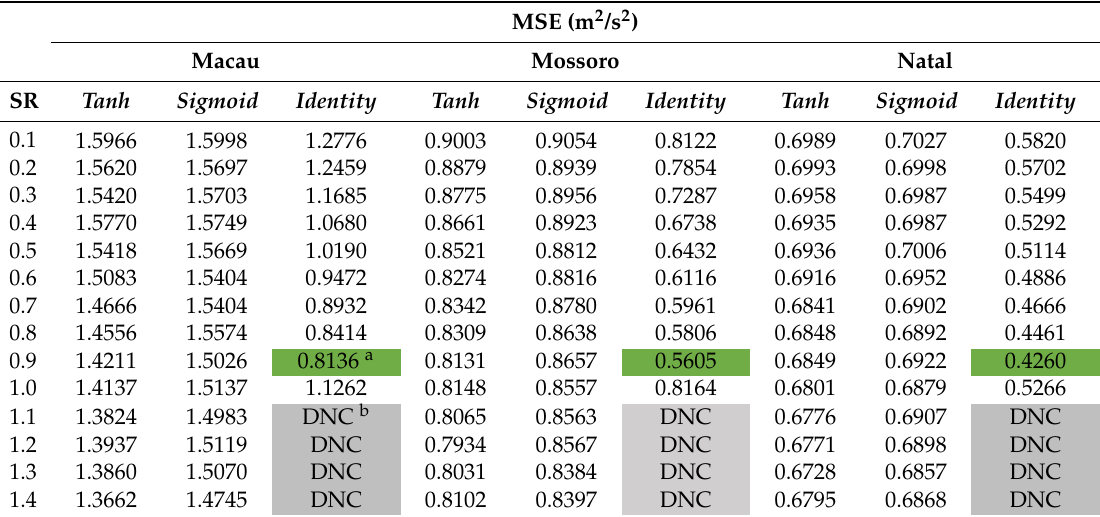
Table 3. Average MSE for the test sets.